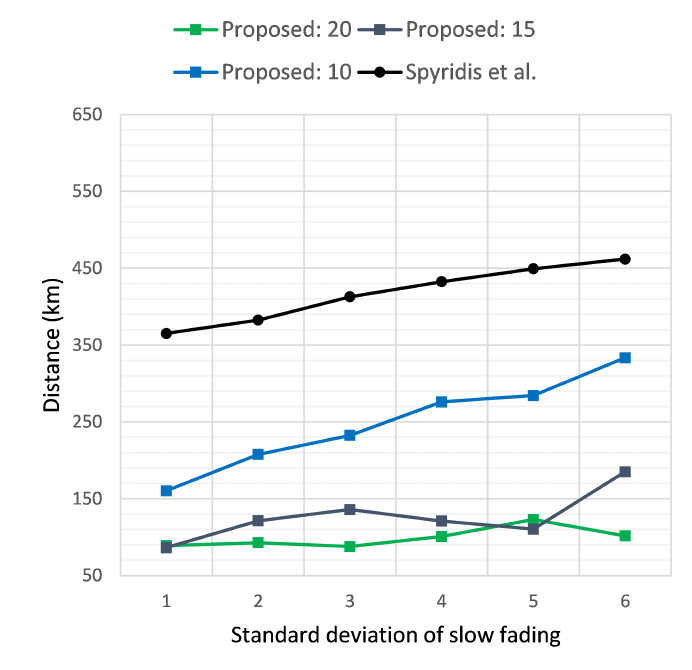
Figure 8. Total distance covered by all UAVs when the target sensor is placed at a distance of 2 km, versus the standard deviation σ of the additive noise. Comparison of the proposed method at clustering termination thresholds of 20, 15 and 10 dB and the previous